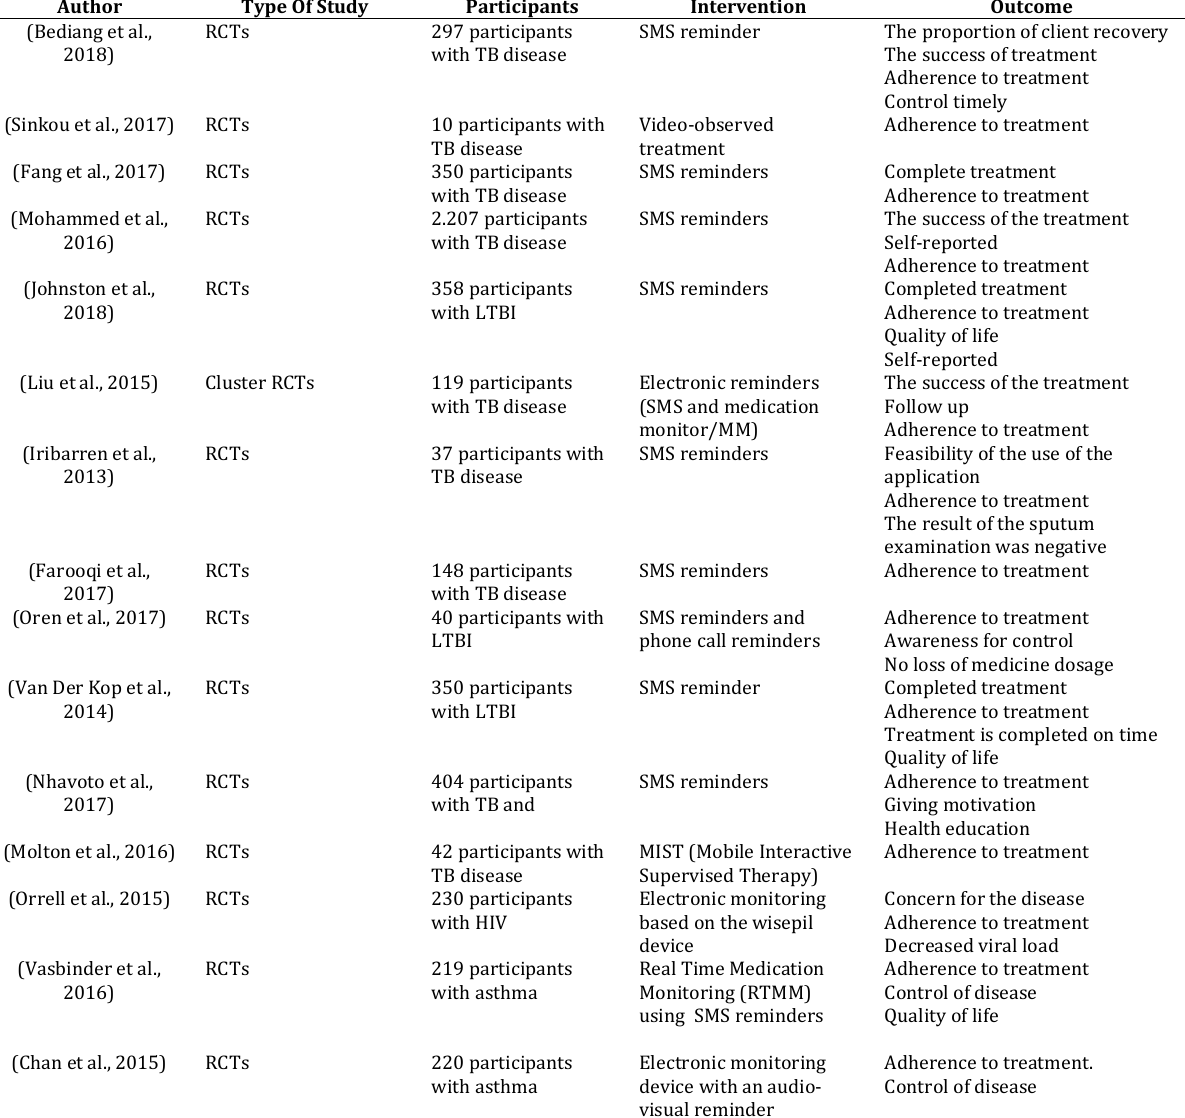
Table 1. The randomized controlled trial studies which were included in the systematic